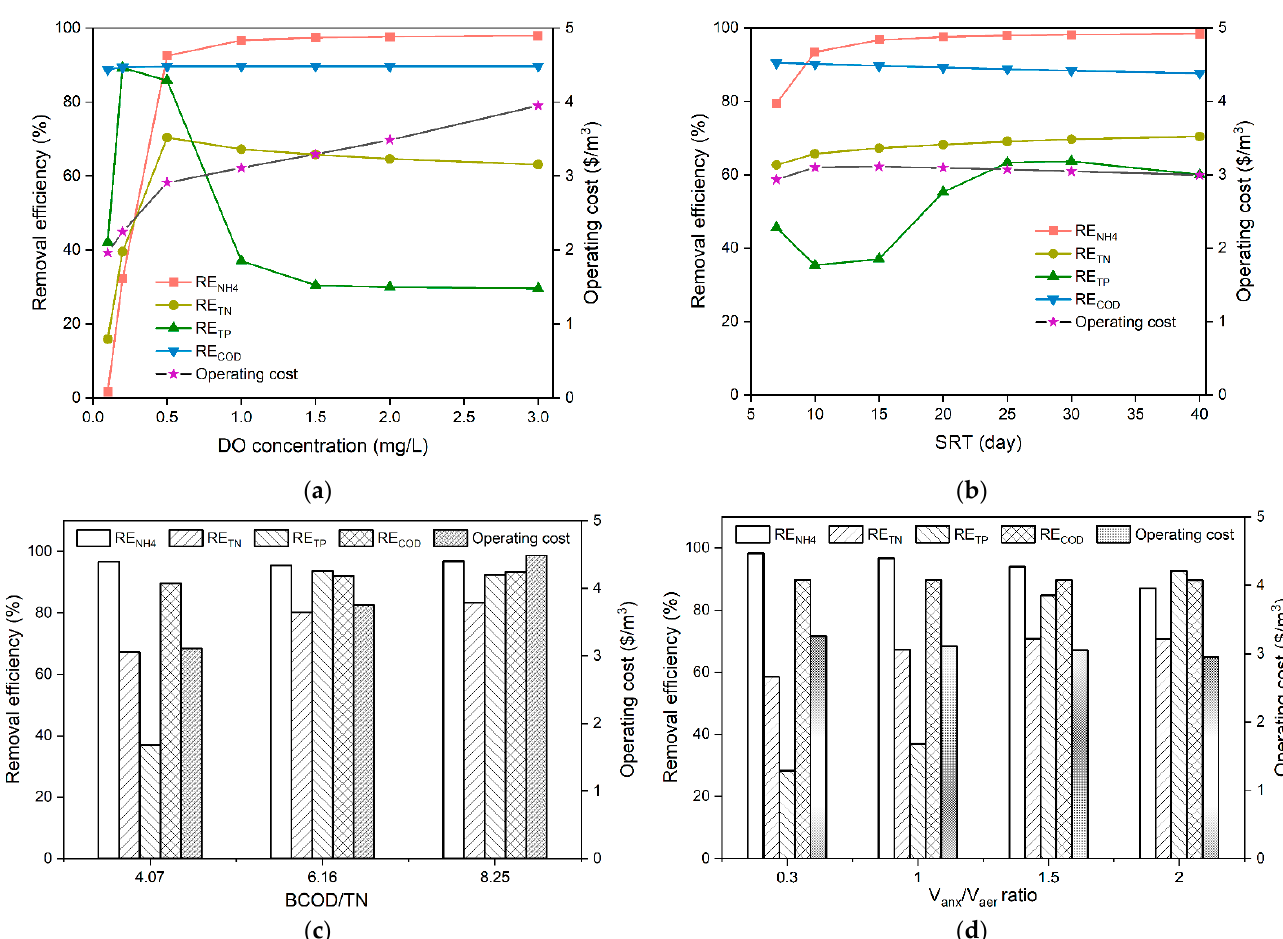
Figure 2. Simulated results for the removal efficiencies of NH 4+ -N(RE NH4 ), TN(RE TN ), TP(RE TP ), COD(RE COD ), and the operating cost with the change of ( a ) DO concentration; ( b ) SRT; ( c ) BCOD/TN; ( d ) V anx /V aer ratio. The initial values of the DOPs were as follows: DO = 1.0 mg/L, SRT = 15 days, BCOD/TN = 4.07, V anx /V aer ratio =